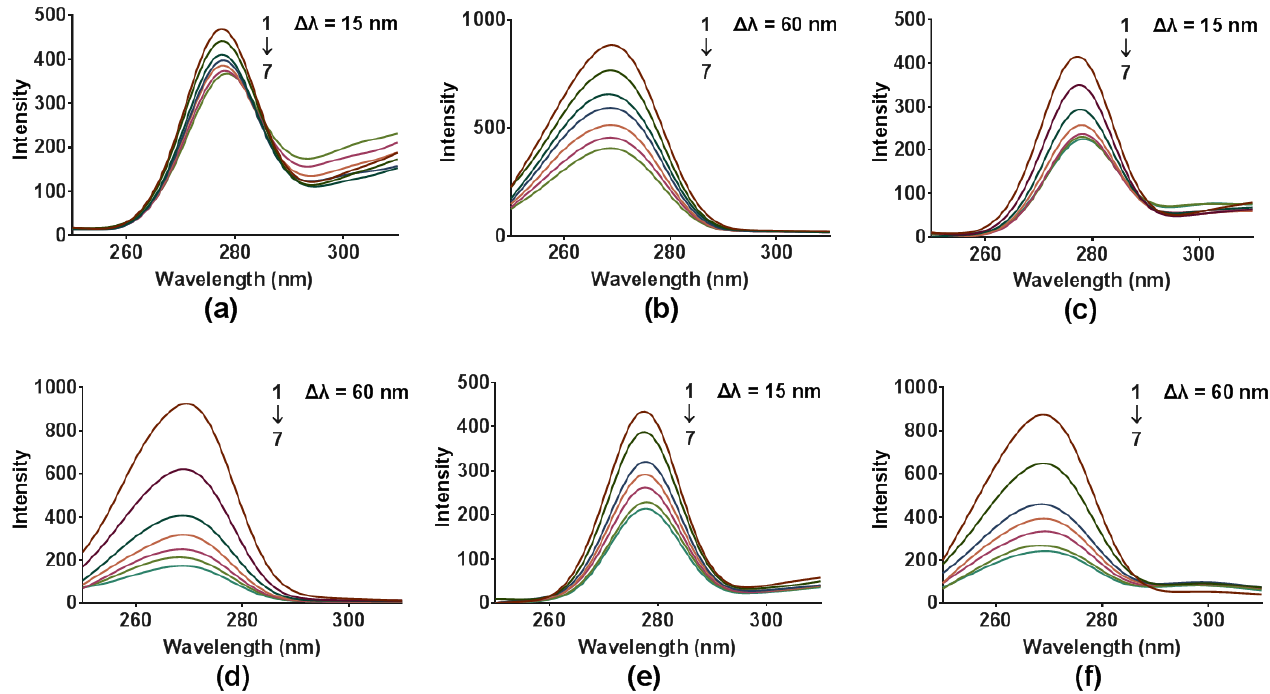
Figure 6. Synchronous fluorescence spectra of COX2 (6.0 × 10 − 8 mol · L − 1 ) in the presence of different concentrations of compounds DB2 ( a , b ), SC2 ( c , d ) and YB2 ( e , f ) (1 → 7: 0, 0.75, 1.50, 2.25, 3.00, 3.75, 4.50 × 10 − 5 mol · L − 1 ) at 298 K.